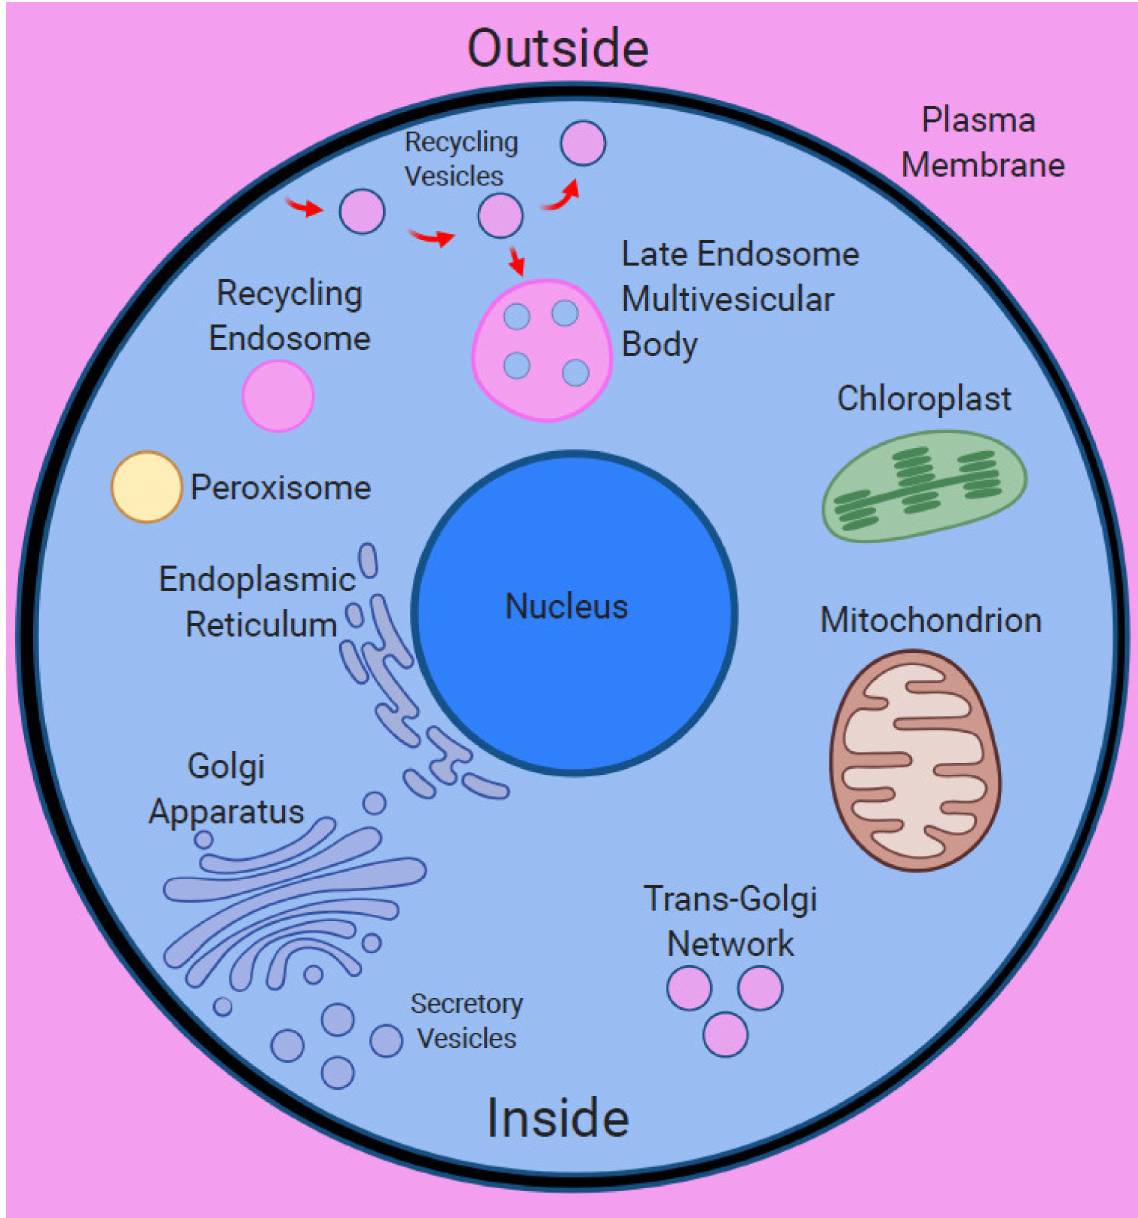
Figure 2. Surfaces within surfaces—endomembrane system of the eukaryotic cell. The eukaryotic cell has chimeric nature due to the endosymbiotic origin of its major organelles. The plasma membrane encloses diverse organelles as well as endocytic vesicles and endosomes, representing the surfaces within surfaces situation. Importantly, endocytic vesicles enclose portions of the extracellular space, representing unique outside within inside